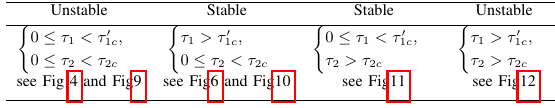
STABILITY REGIONS IN CASE OF TWO NON - ZERO DELAYS Unstable